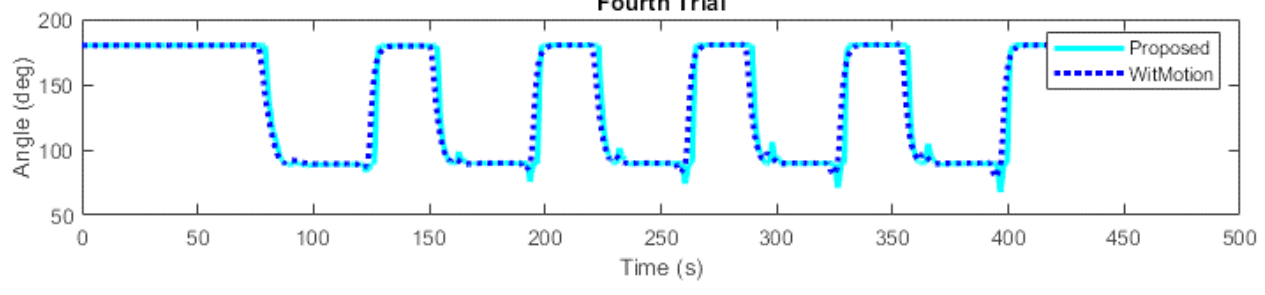
Figure 9. Measured angle using proposed algorithm (PA) and WitMotion (WM) (fourth trial). Table 8. Performance